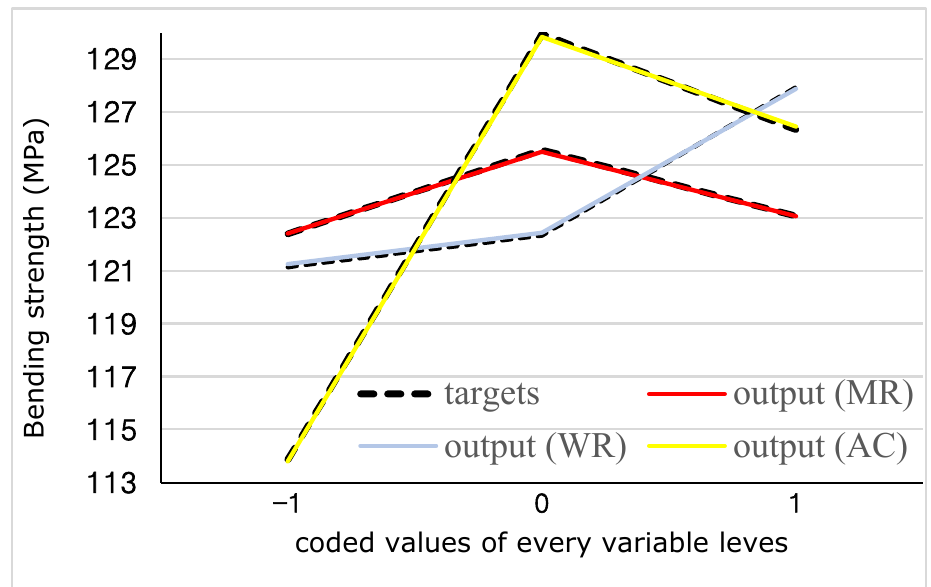
Figure 9. The direct real and estimated effect of the variables on the bending strength.